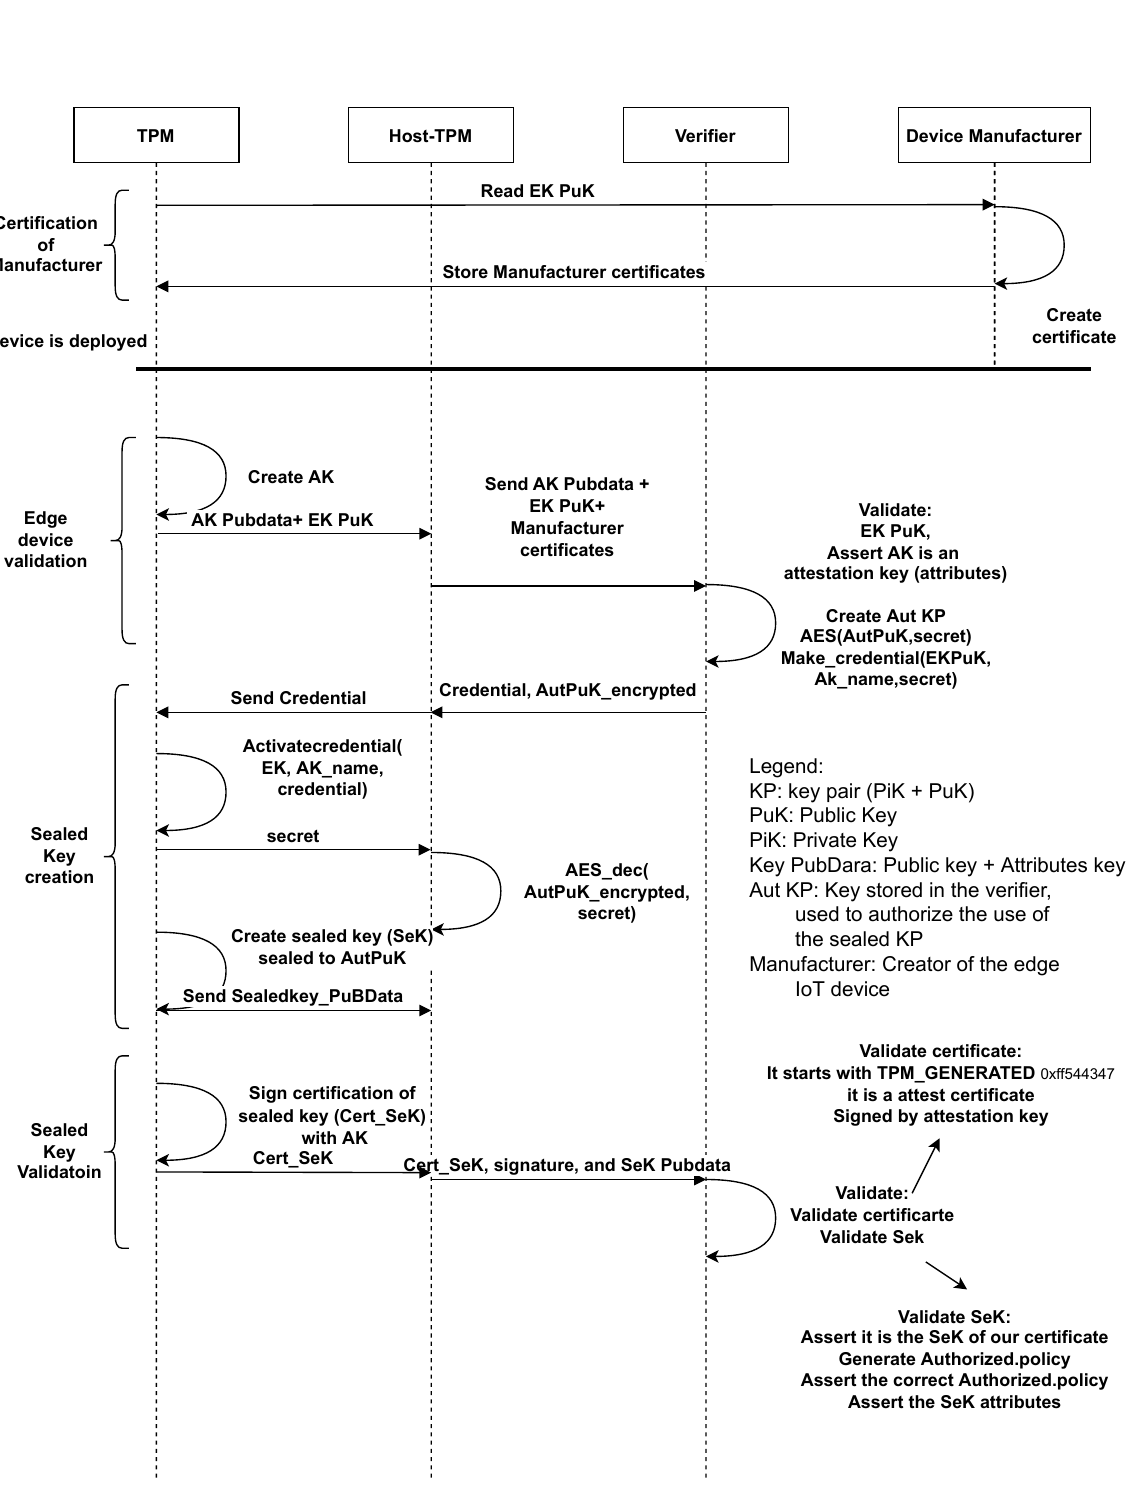
Figure 1. Remote enrollment process. The scheme represents all the enrollment process from the device manufacturer to the supervised creation of the sealed